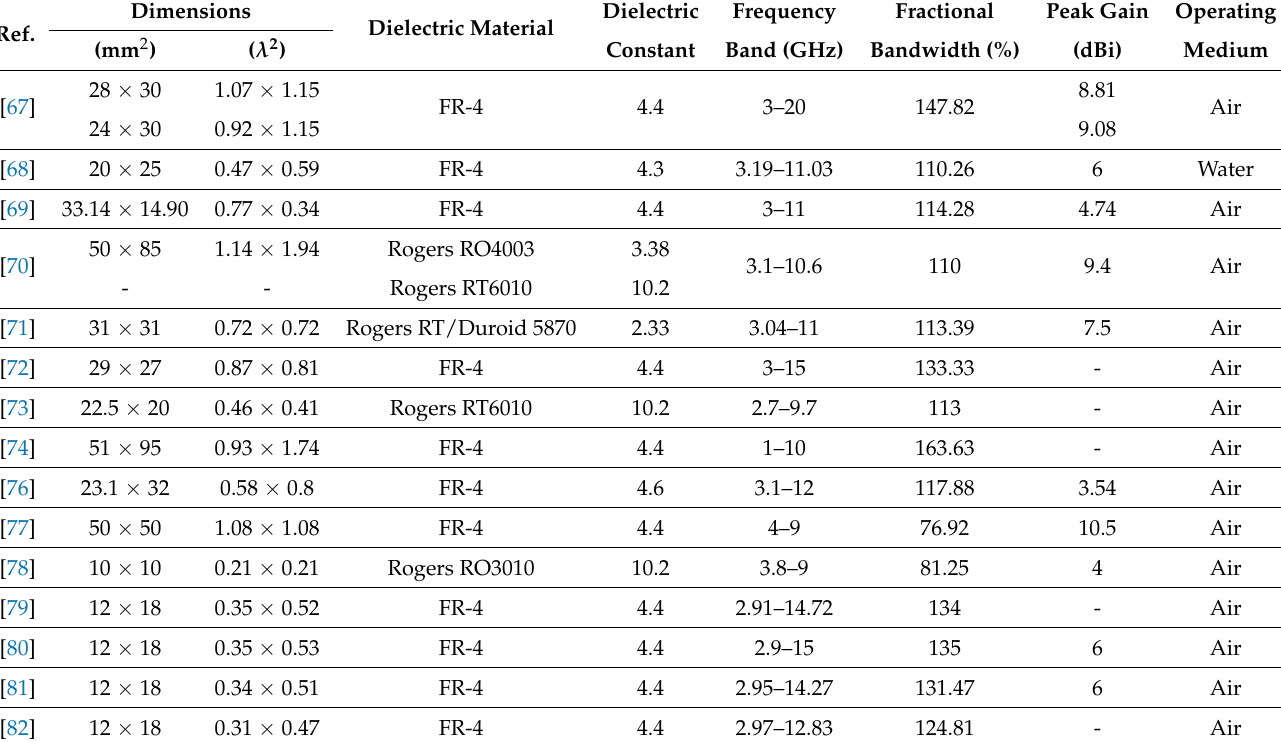
Table 3. Comparative analysis among planar monopole antennas for biomedical